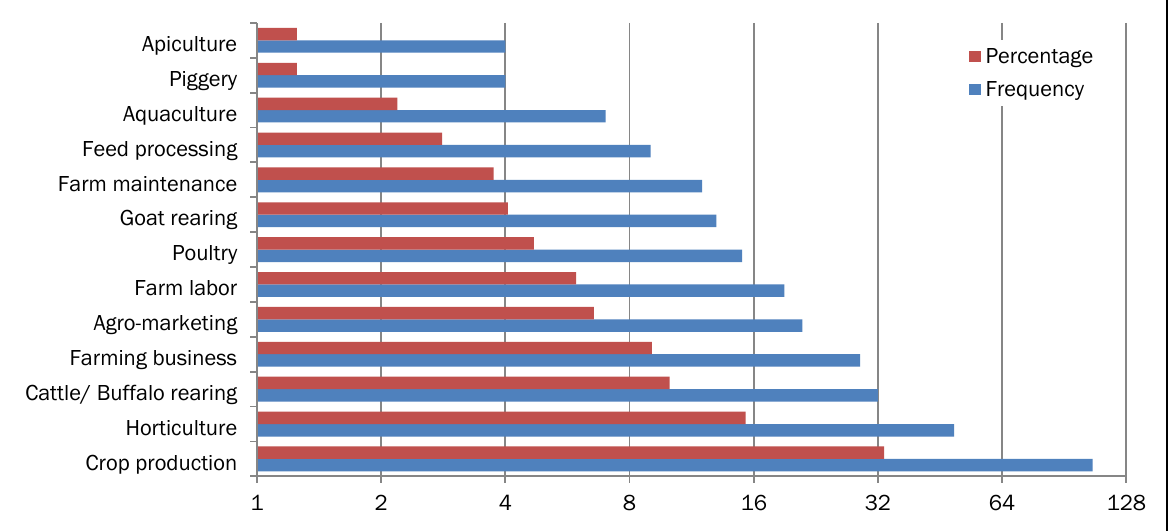
Figure 3. Level of Youth Involvement in Agro-Enterprises The red bar represents the percentage of each category of engagement field; the blue bar represents the number of respondents ( N